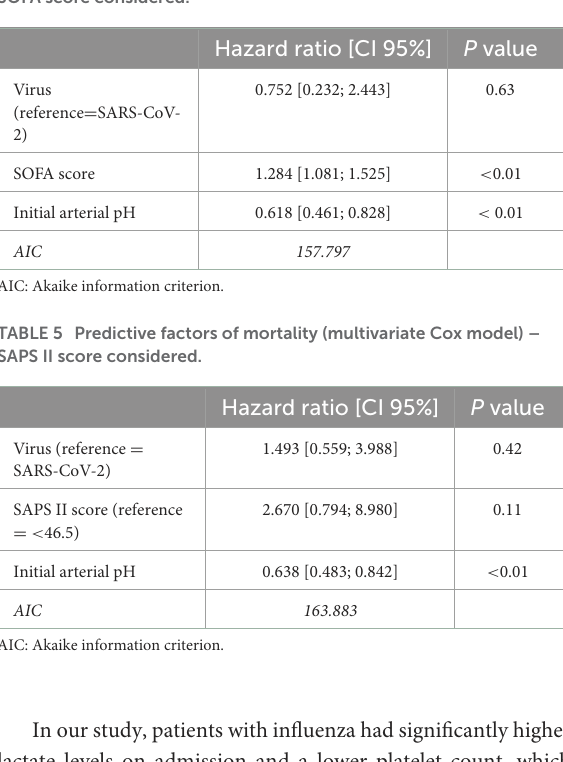
TABLE 3 Predictive factors of mortality (univariate Cox models results).